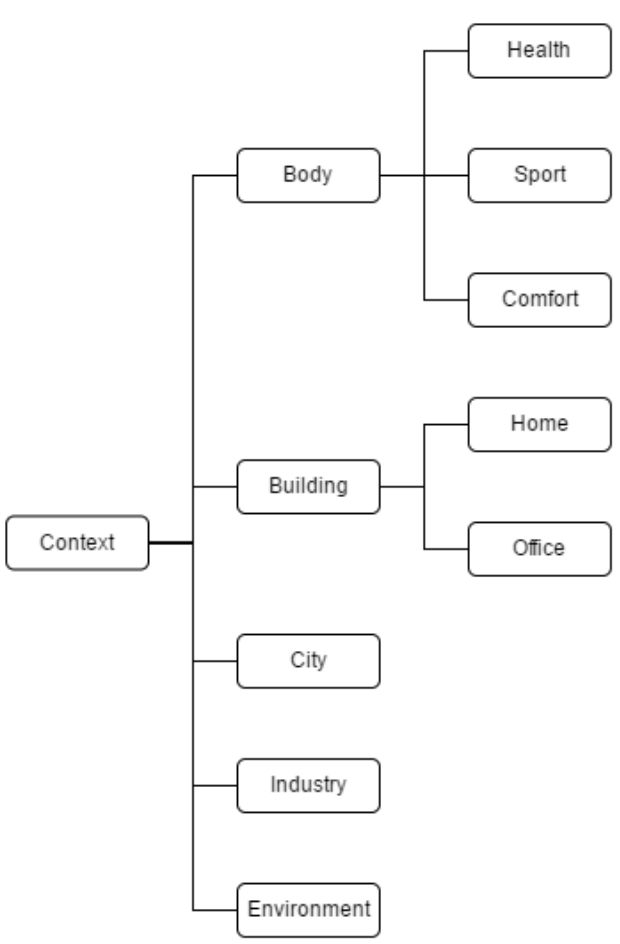
Figure 1. The Context category of the